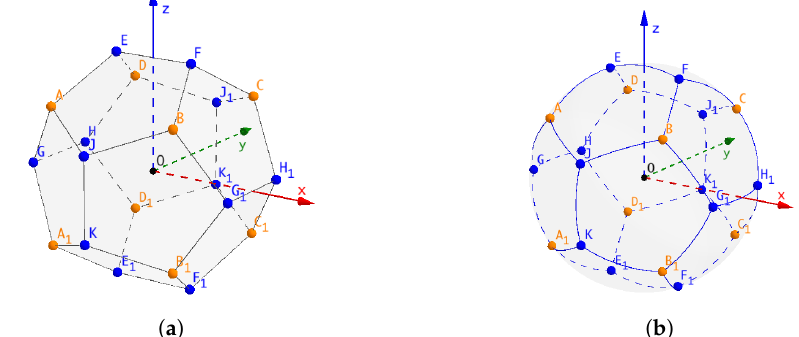
Figure 1. ( a ) The vertex distribution of the dodecahedron, with 8 orange vertices at ( ± 1, ± 1, ± 1 ) , ) , ( ± 1 and 12 blue vertices at ( 0, ± φ , ± 1 ,0, ± φ ) , and ( ± φ , ± 1 ,0 ) ( O is the center of the sphere and φ φ φ ≈ 1.618.); ( b ) the projection of all the dodecahedron’s edges divides the sphere into φ = 4 √ 5 + 1 12 identical sections.